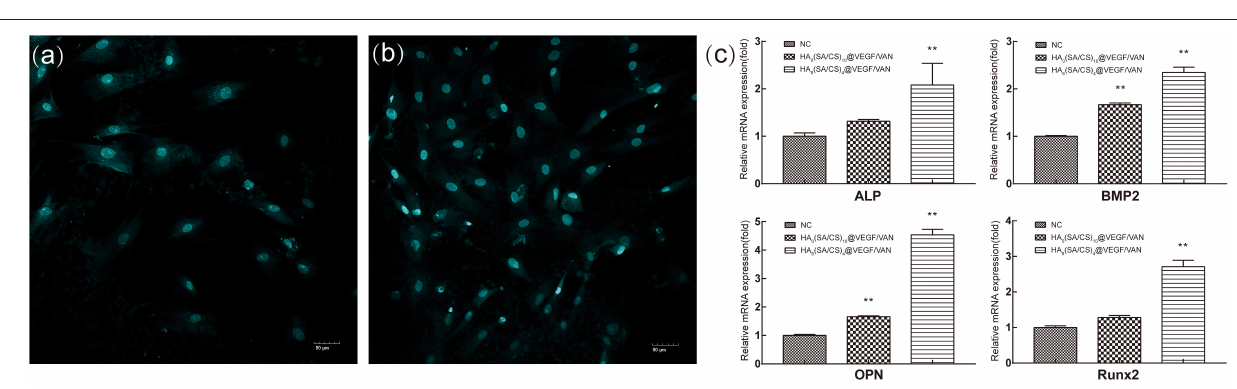
osteoblasts in the early stage of maturation, while Runx2 is